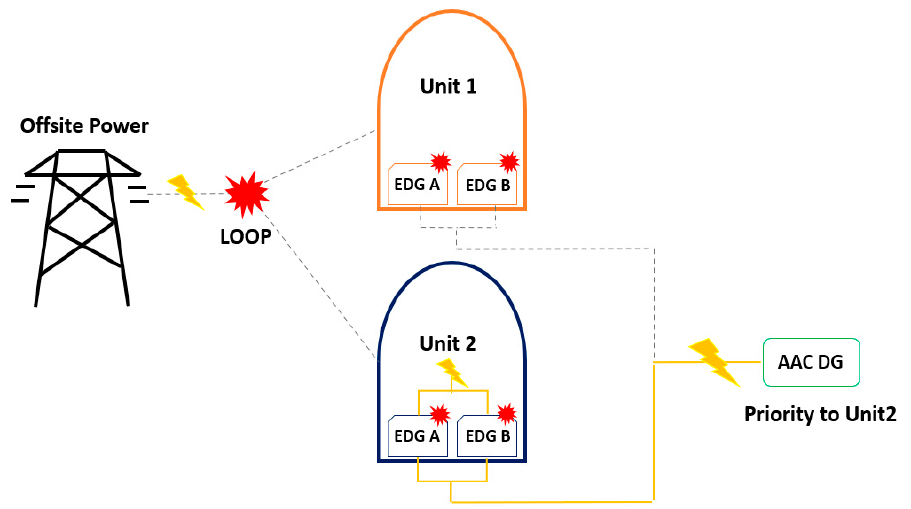
Figure 9. An accident in which the EDGs are unavailable for both Units 1 and 2, but Unit 2 has AAC DG